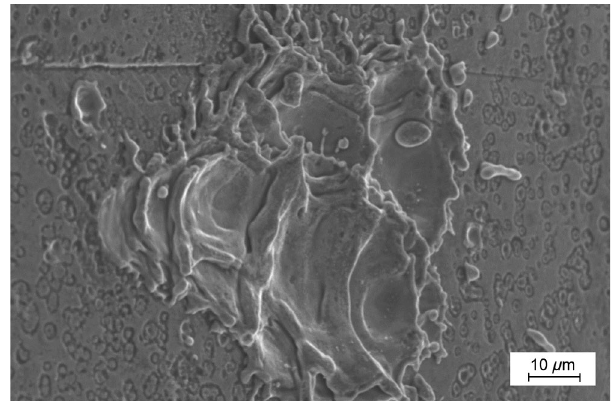
FIG. 5. Example of a crater after a breakdown on the surface of a copper rf cavity [21].